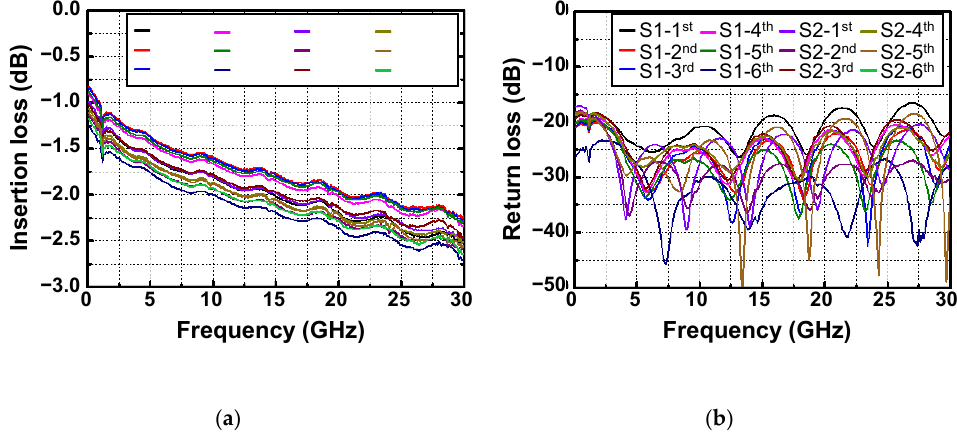
Figure 9. Measured S-parameter results of twelve InP-to-SiC CPW lines with a hundred μ-bumps arranged in two flip-chip-bonded samples: ( a ) insertion loss; ( b ) return loss.